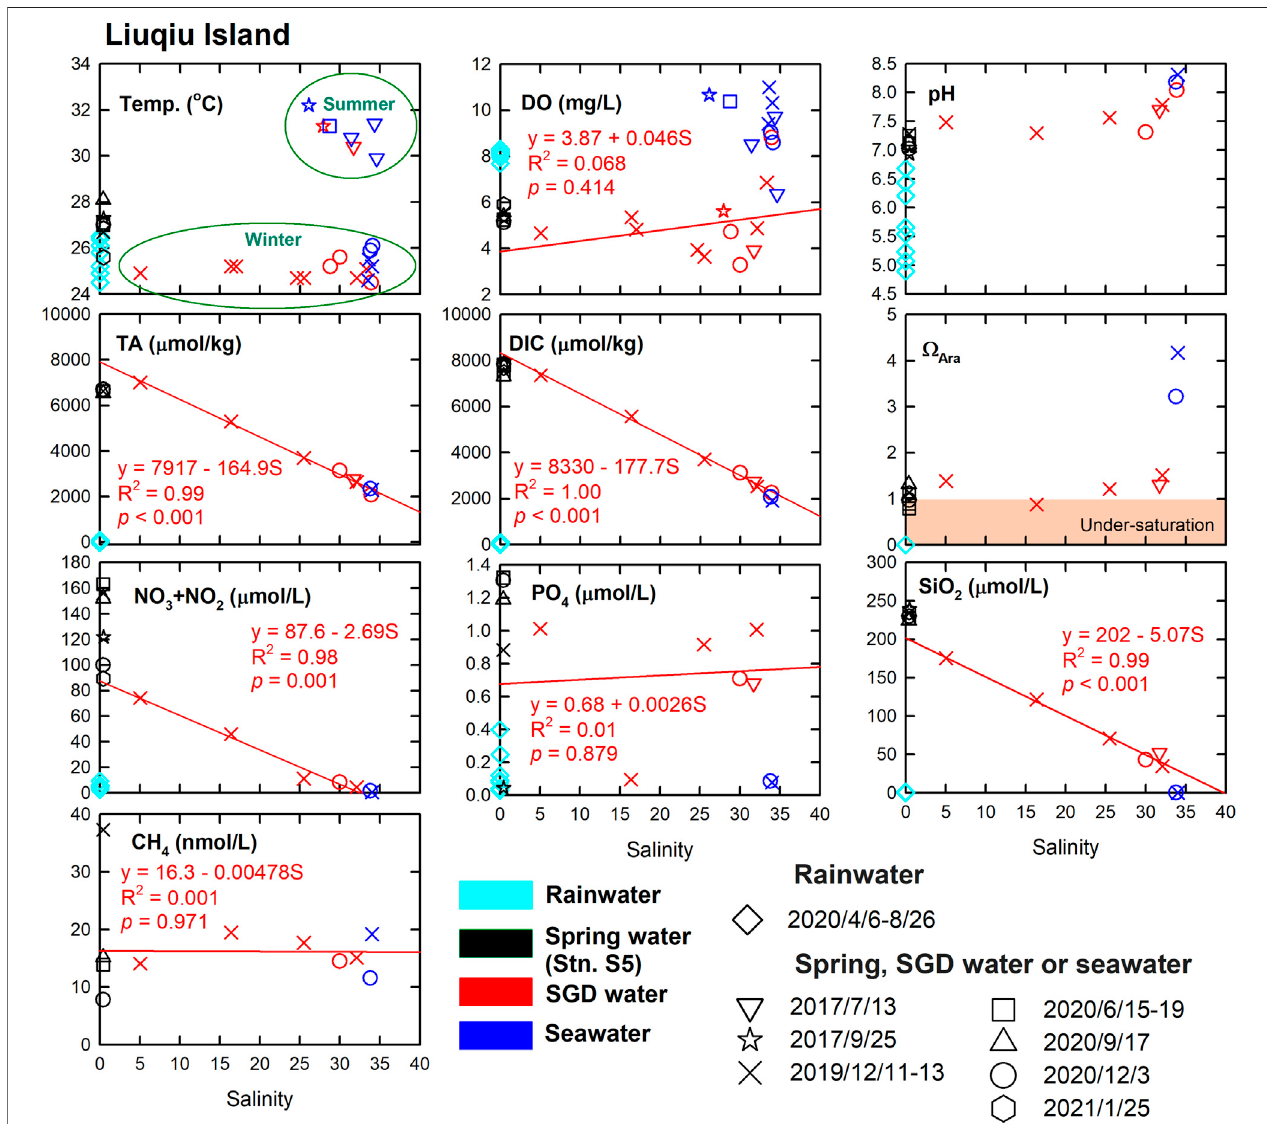
FIGURE 5 | Temperature, DO, pH, TA, DIC, Ω Ara , NO 3 − + NO 2 − , PO 4 3 − , SiO 2 , and CH 4 vs. salinity of rainwater, spring water, SGD water, and seawater in Liuqiu Island.Therainwater,springwater,SGDwater, and seawater areinlightblue, black, red,and blue, respectively. Thered lines extended tothe axes and equations show the linear regressions for the conservative parameters of the SGD